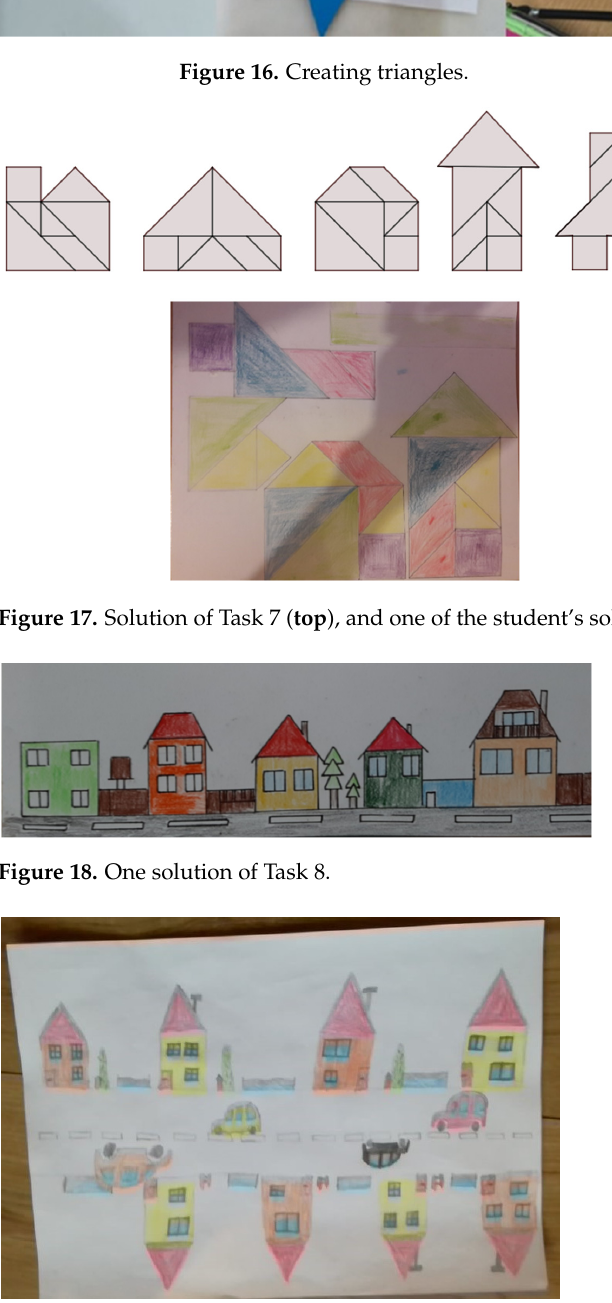
Figure 16. Creating triangles.